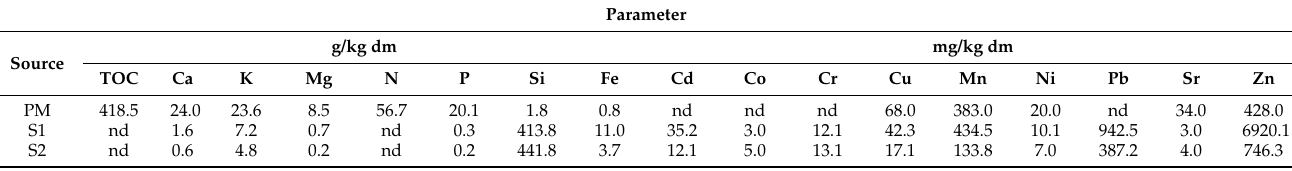
Table 1. Physicochemical properties of the soils and poultry manure used in the investigations [37].